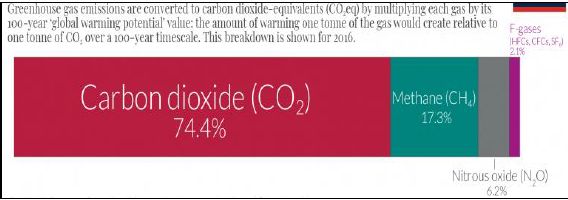
Figure 1. Global greenhouse gas emissions